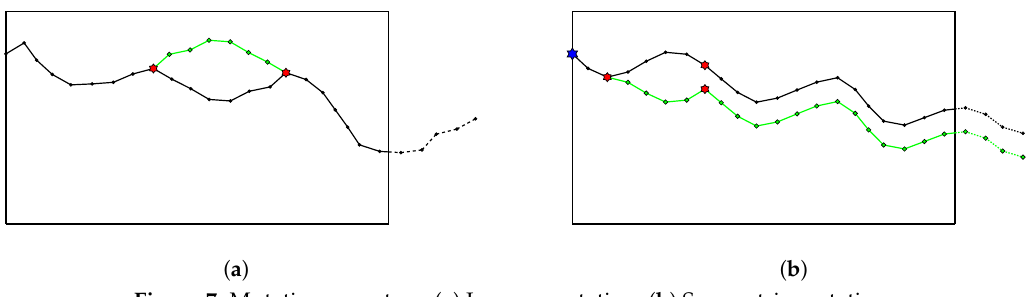
Figure 7. Mutation operators: ( a ) Inverse mutation. ( b ) Symmetric